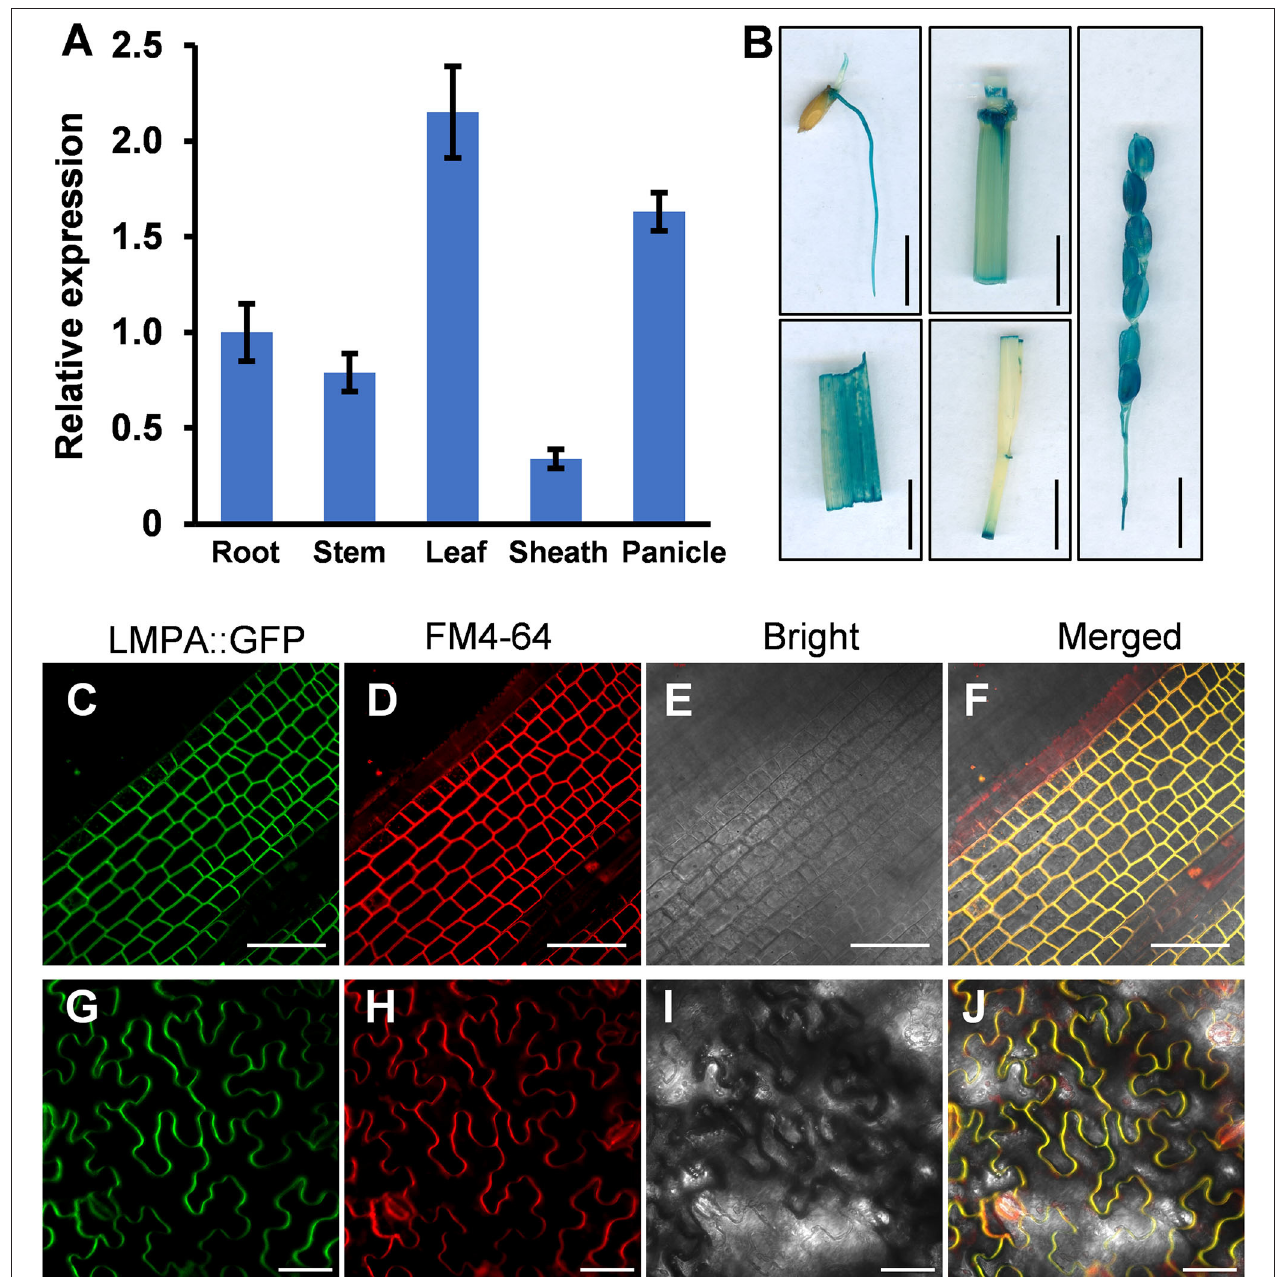
FIGURE 7 | Expression pattern and subcellular localization of the LMPA protein. (A) Relative expression of LMPA in various tissues. (B) Tissue-specific expression of the GUS gene driven by the LMPA promoter. (C–J) Plasma membrane localization of LMPA in LMPA-GFP transgenic plants (C–F) and leaf cells of N. benthamiana (G–J) . FM4-64 was used as a membrane marker. Error bars represent standard deviation (SD) ( n = 3). Bars = 1cm in (B) , 50 µ m in (C–J) .